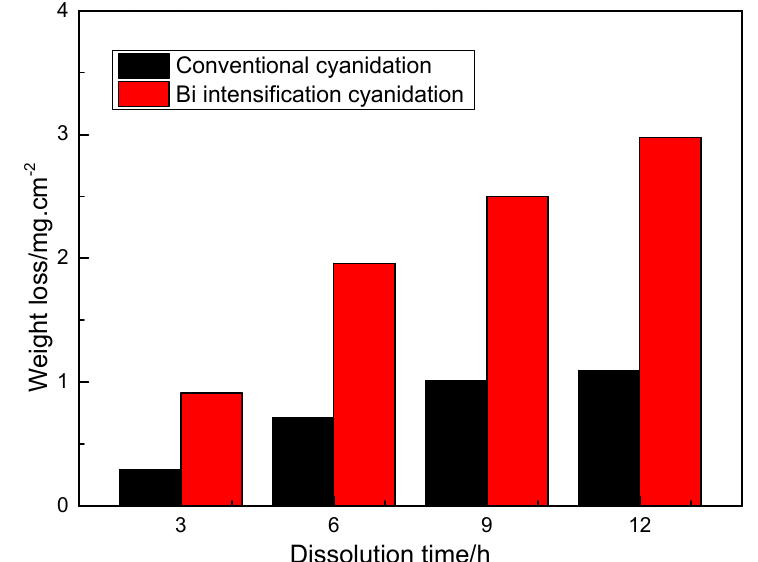
Figure 1. Time course of gold dissolution for conventional and Bi intensification cyanidation.